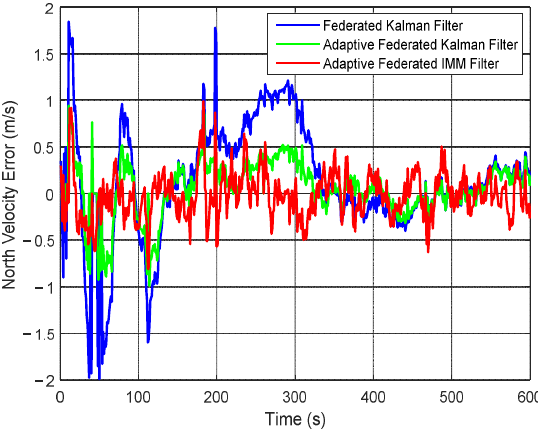
Figure 16. The estimation curves of north velocity error.